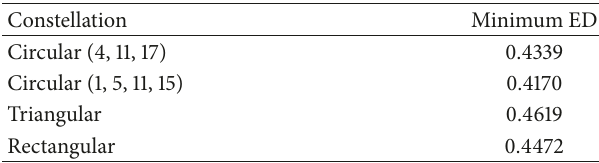
Table 1: Minimum EDs of different constellation shaping schemes. Constellation